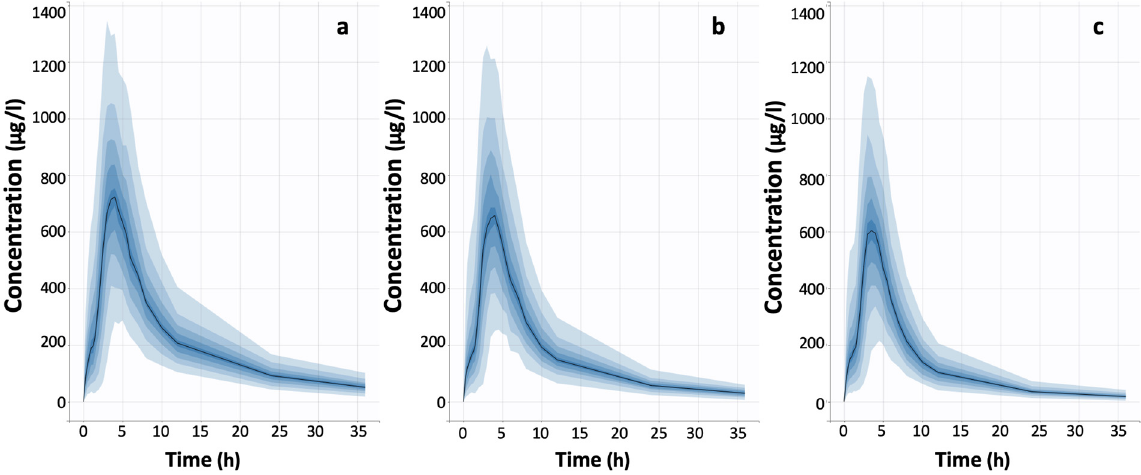
Figure 3. Simulated concentration vs. time profiles of amisulpride for three values of weight distribution: ( a ) 50 Kg; ( b ) 70 Kg; and ( c ) 100 Kg. In each group, 1000 individuals were generated.